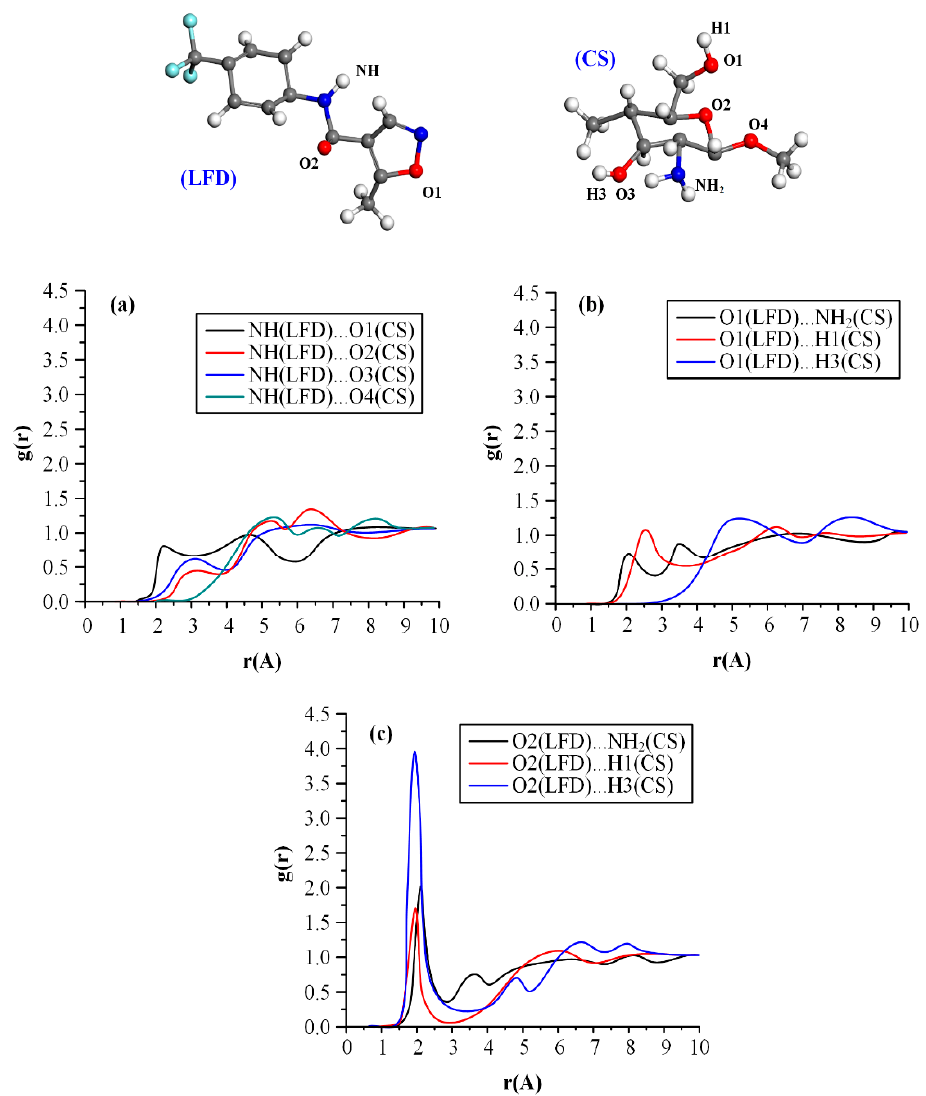
Figure 5. Radial distribution function, g(r), between LFD’s –NH proton donor H1 with CS’s HB acceptors O1–O4 ( a ) as well as LFD’s proton acceptors O1 ( b ) and O2 ( c ) with CS’s HB proton donors